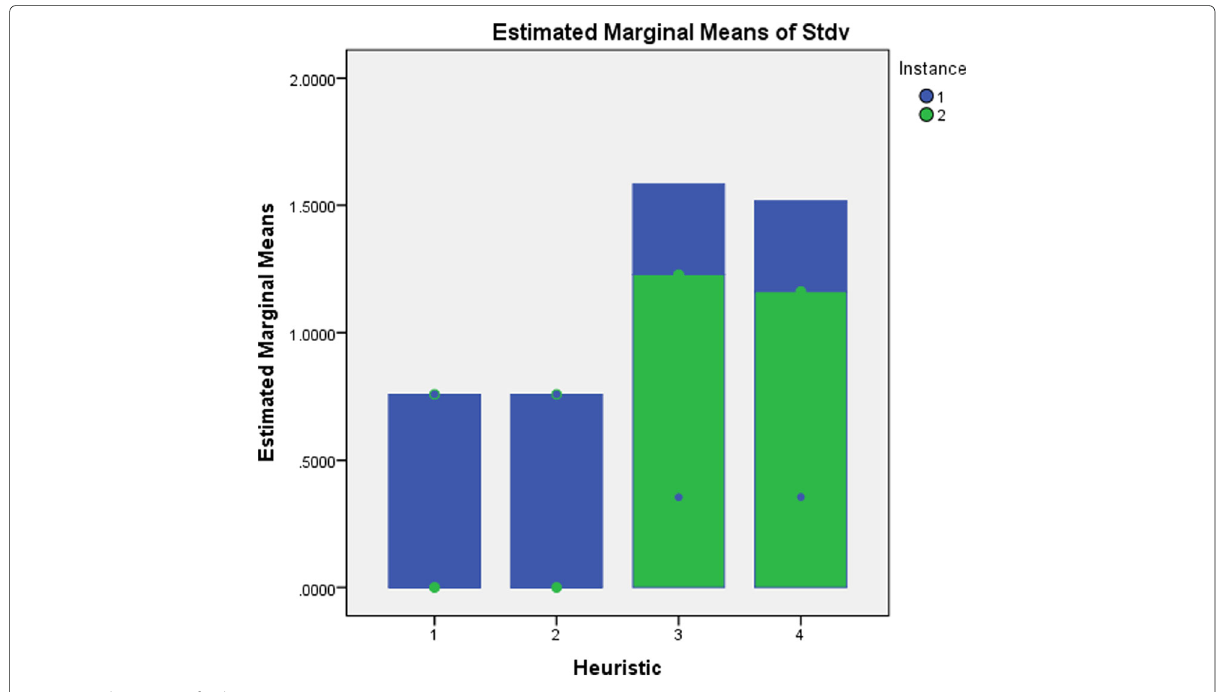
Fig. 13 Robustness of solution - 1